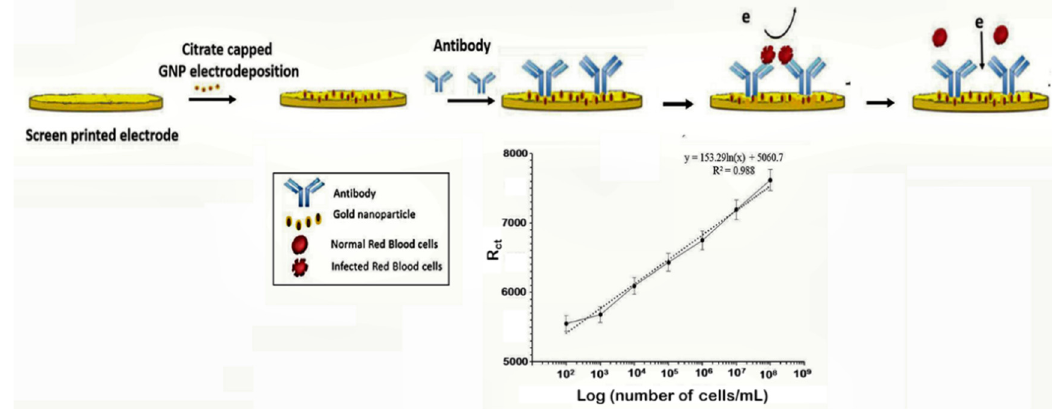
Figure 6. Schematic design of the impedimetric sensor malaria-infected RBCs and corresponding calibration plot. (Reprinted from Kumar et al. [47] with permission from the Royal Society of Chemistry).